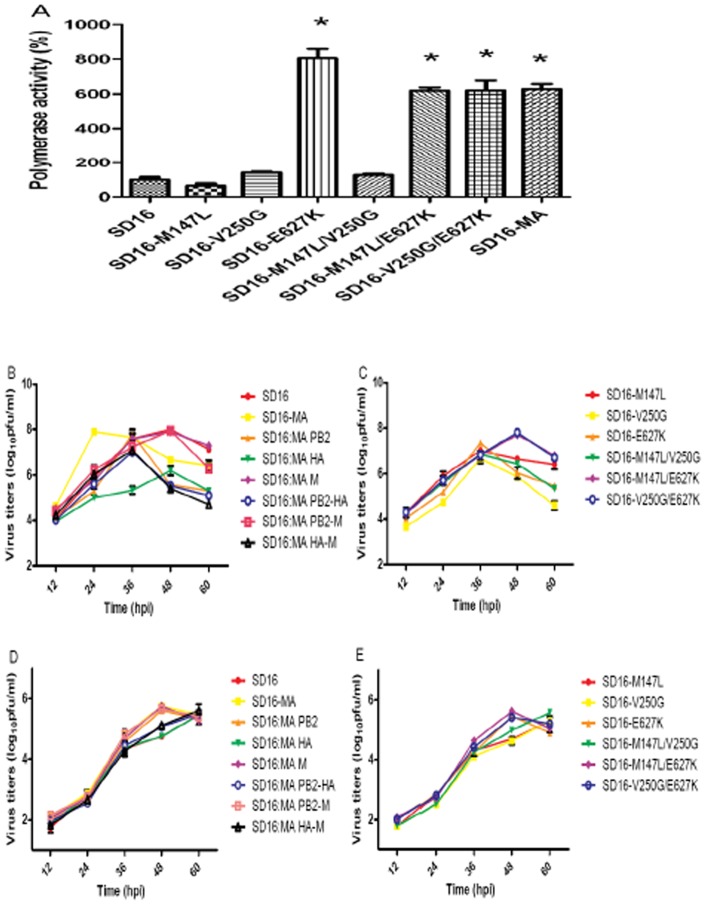
Viral RNA polymerase activity and Viral growth kinetics in MDCK and A549 cells.(A) Polymerase activity of SD16 with different PB2 mutations in a minigenome assay. Four protein expression plasmids (PB2, PB1, PA, NP) for the RNP combinations were transfected into 293T cells together with luciferase reporter plasmid pYH-Luci and internal control plasmid Renilla, as described in Materials and Methods. The values shown are means ± SD of results for three independent experiments and are standardized to the activity of SD16 (100%). *, P<0.05 compared with that of SD16-infected cells. (B, C, D, E) Viral growth kinetics of reassortant viruses and PB2 mutants in MDCK and A549 cells. Confluent momolayers of cells were infected with rescued H9N2 viruses at an MOI of 0.01. Cell supernatants were harvested every 12 hours until 60 hpi and titrated by plaque assay on MDCK cells. Each data point represents the mean virus yield from three individually infected wells ± SD. (B) reassortant viruses in MDCK cells, (C) PB2 mutants in MDCK cells, (D) reassortant viruses in A549 cells, (E) PB2 mutants in A549 cells.